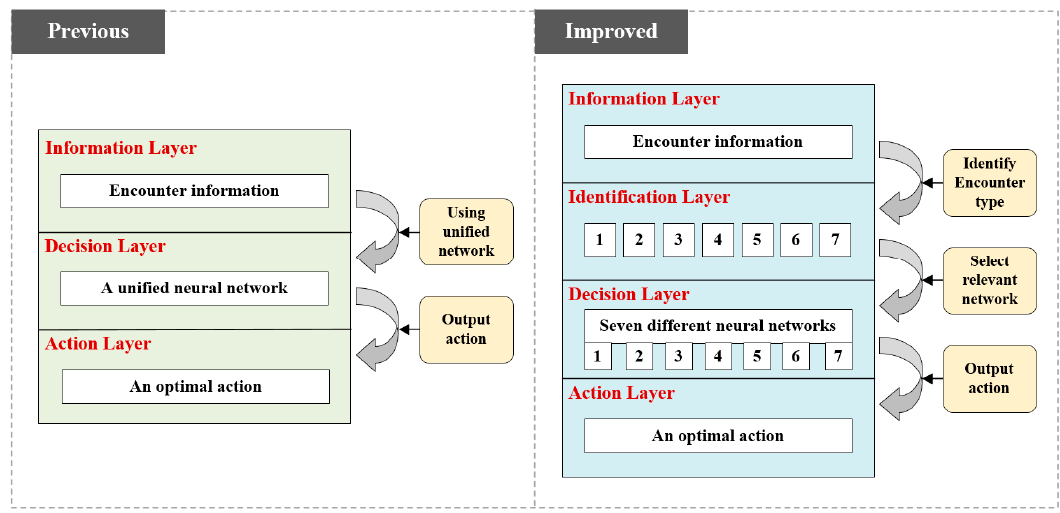
Figure 9. The decision-making process followed by the agent to avoid a collision.